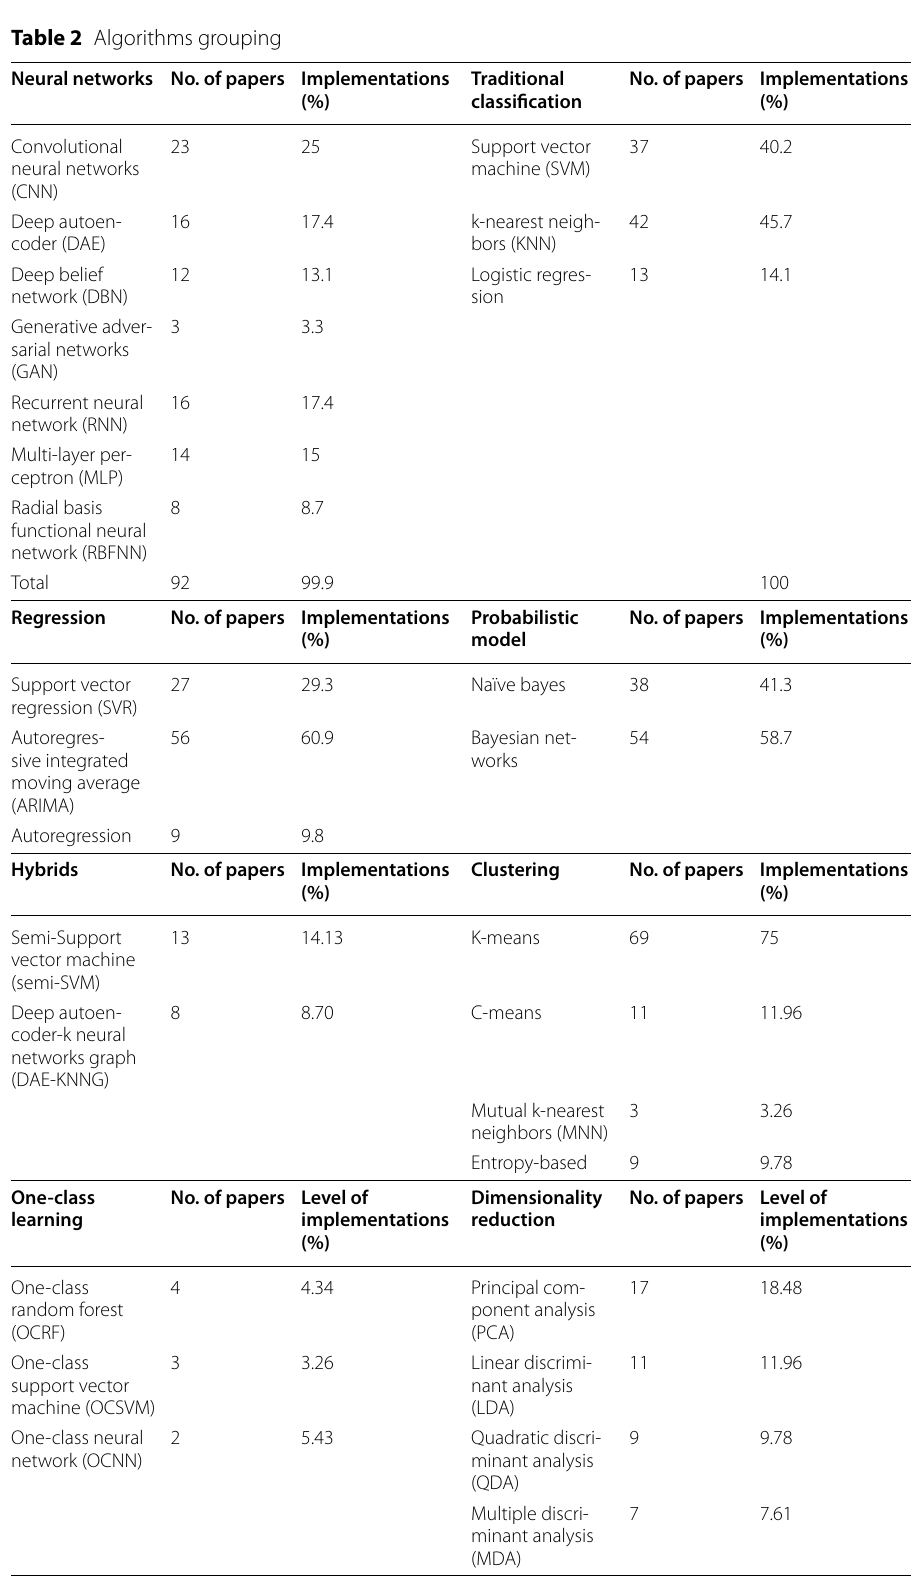
Table 2 Algorithms grouping Neural networks No. of papers Implementations